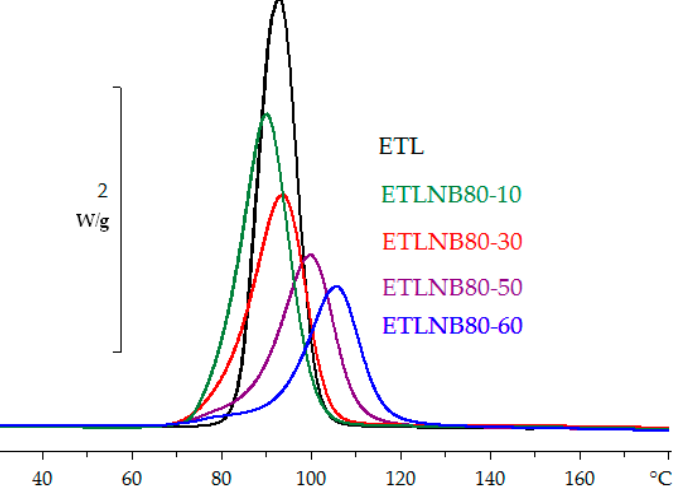
Figure 2. Non-isothermal DSC cure curves for epoxy-thiol system without BN (ETL) (black), ETLBN80-10 (green), ETLBN80-30 (red), ETLBN80-50 (purple), and ETLBN80-60 (blue) at the heating rate of 5 K/min. Exothermic direction is upward. The peak height decreases with increasing BN content.